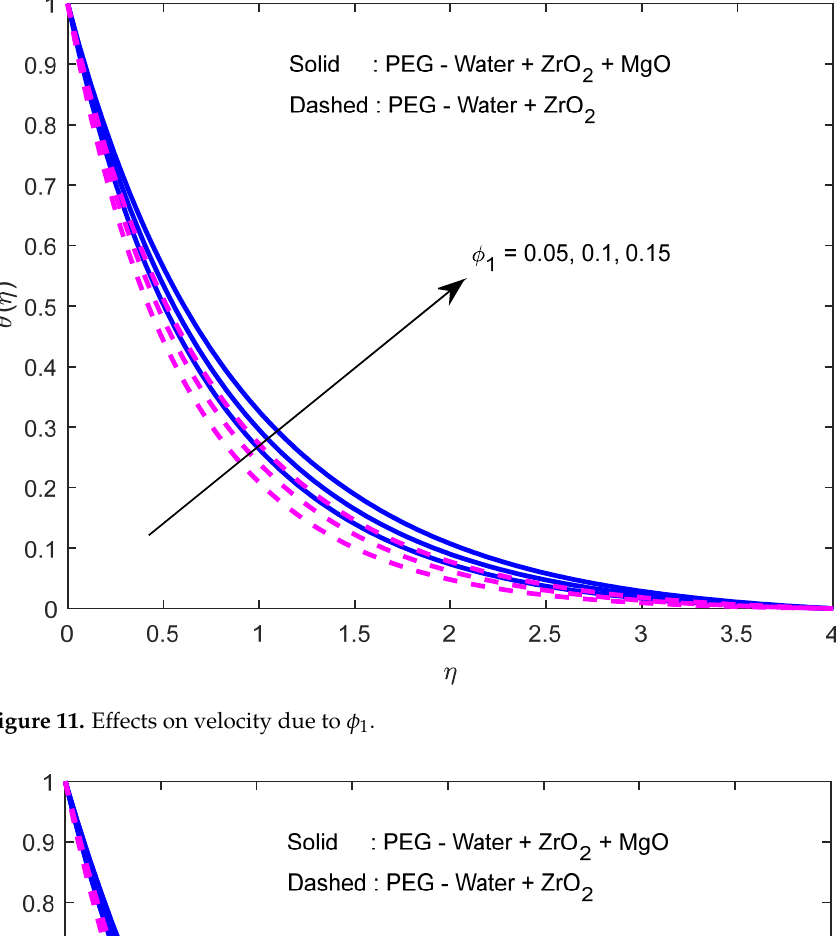
Figure 10. Effects on velocity due to K .